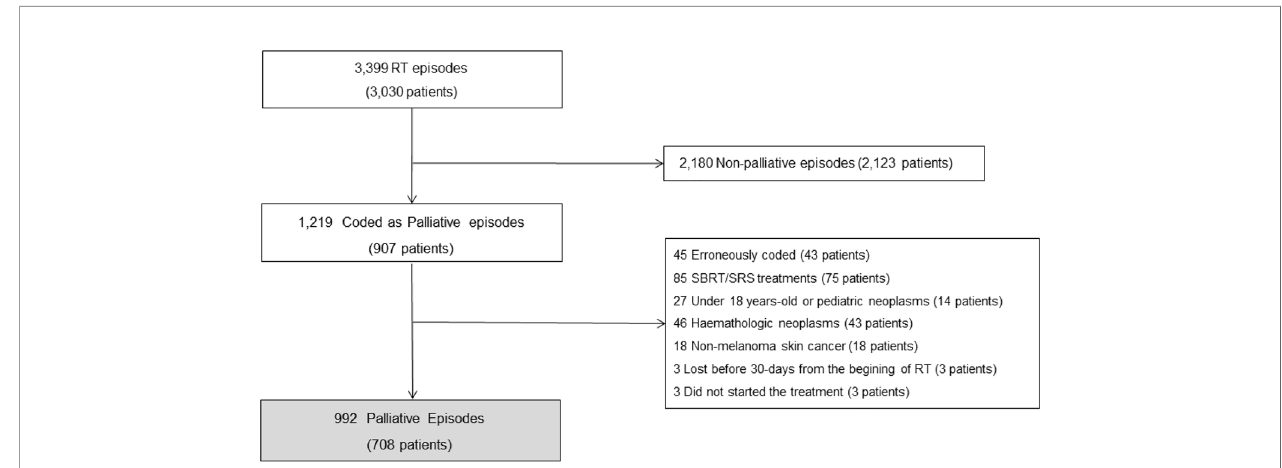
FIGURE 1 | Consort diagram demonstrating exclusions from the study